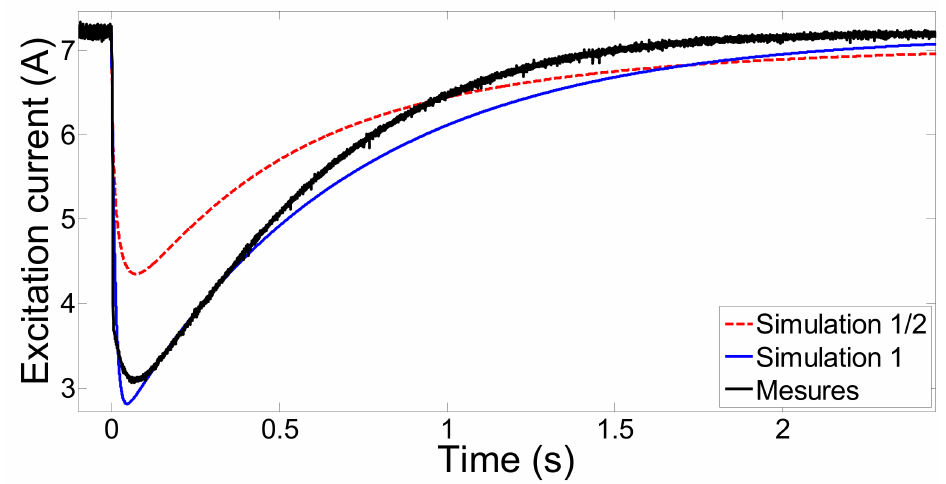
Figure 8. Simulation and measurement of the excitation current during no-load voltage